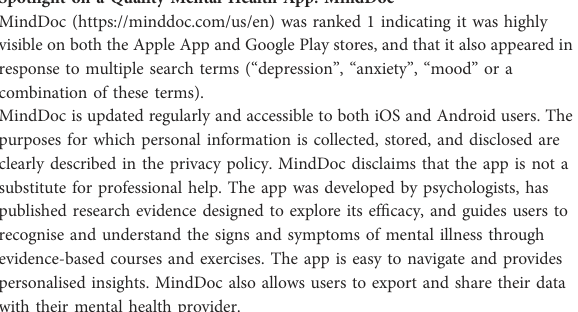
TABLE 2 Qualitative description of app which met all fi ve APA evaluation tool criteria. Spotlight on a Quality Mental Health App: MindDoc MindDoc (https://minddoc.com/us/en) was ranked 1 indicating it was highly visible on both the Apple App and Google Play stores, and that it also appeared in response to multiple search terms ( “ depression ” , “ anxiety ” , “ mood ” or a combination of these terms). MindDoc is updated regularly and accessible to both iOS and Android users. The purposes for which personal information is collected, stored, and disclosed are clearly described in the privacy policy. MindDoc disclaims that the app is not a substitute for professional help. The app was developed by psychologists, has published research evidence designed to explore its ef fi cacy, and guides users to recognise and understand the signs and symptoms of mental illness through evidence-based courses and exercises. The app is easy to navigate and provides personalised insights. MindDoc also allows users to export and share their data with their mental health